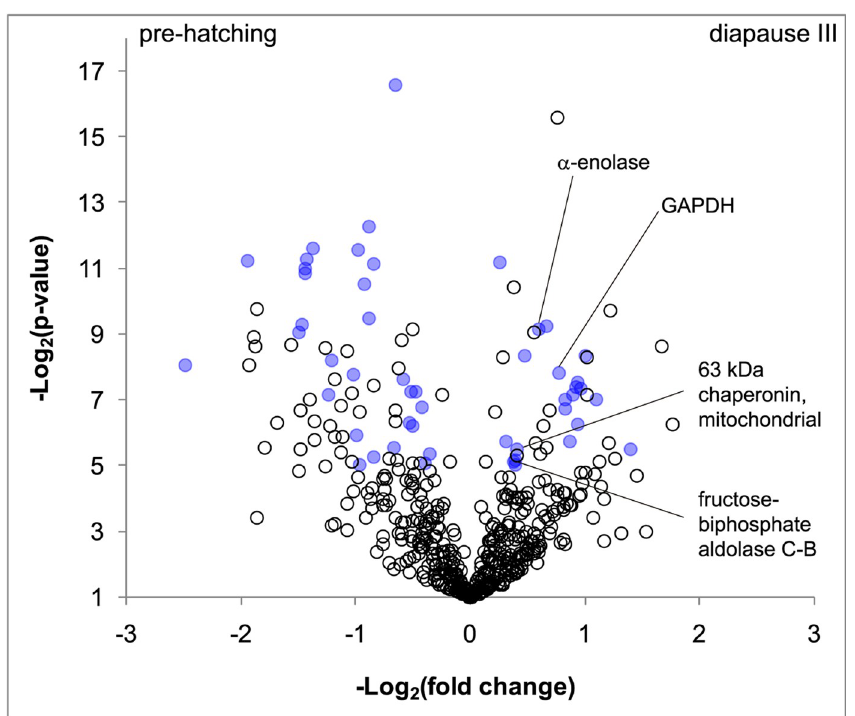
Fig 3. Volcano plot. Volcano plot indicating proteins present in both sample sets but with a significant difference in relative abundance according to spectrum counts. Each spot represents one protein. In the y-axis, Log2 (p-value) is indicated. In the x-axis, Log2 (fold-change) is shown (negative values indicate proteins overrepresented in prehatching (PRE) samples, and positive values show proteins overrepresented in diapause III (DIA) samples). Blue dots correspond to proteins that show a significant difference in relative abundance between conditions. Proteins of interest are